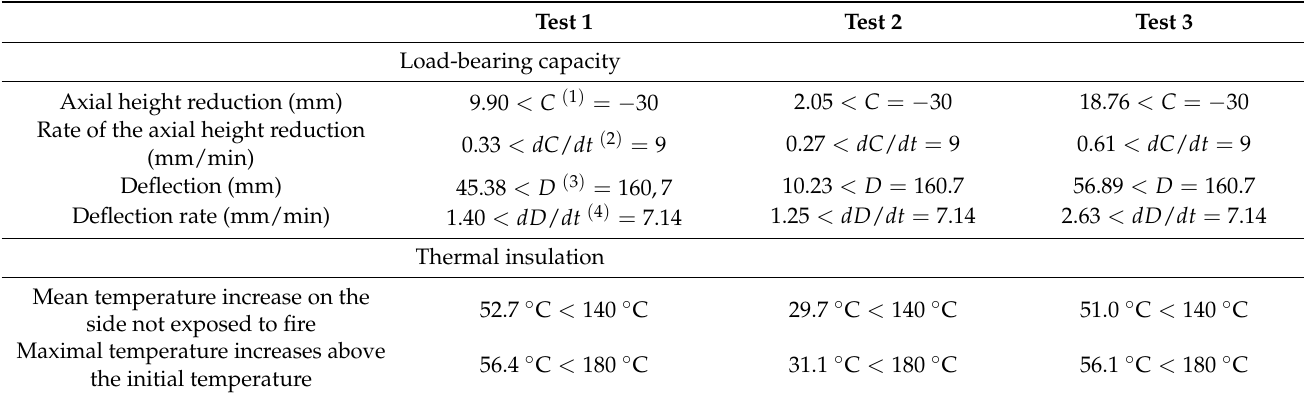
Table 2. The performance criteria according to DIN EN 13501-2 for load-bearing members with a space-enclosing